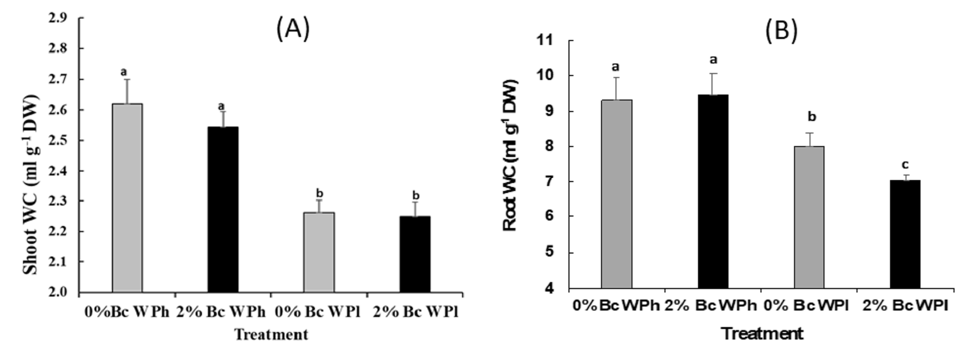
Figure 3. Shoot water content ( A ) and root water content ( B ) in Medicago ciliaris after 3 weeks of drought treatment. Values represent mean ± SE ( n = 5) and the different letters a to c indicate significant differences between the treatments. Low soil water potential (WPl), high soil water potential (WPh), Biochar (Bc).